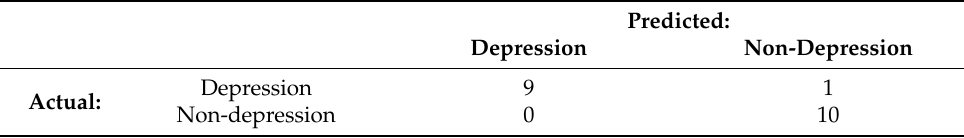
Table 9. Confusion matrix of RFC for the depression